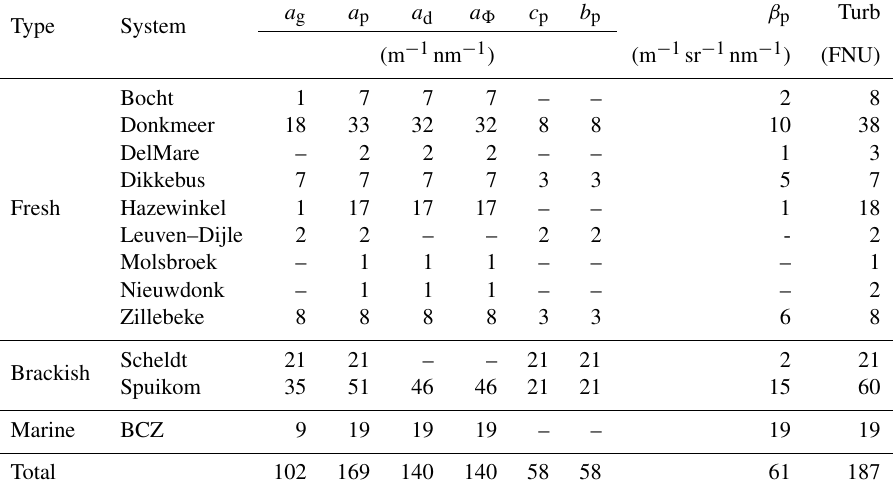
Table 3. Summary of measured and derived inherent optical properties per water system. Values indicate the number of valid, quality-checked